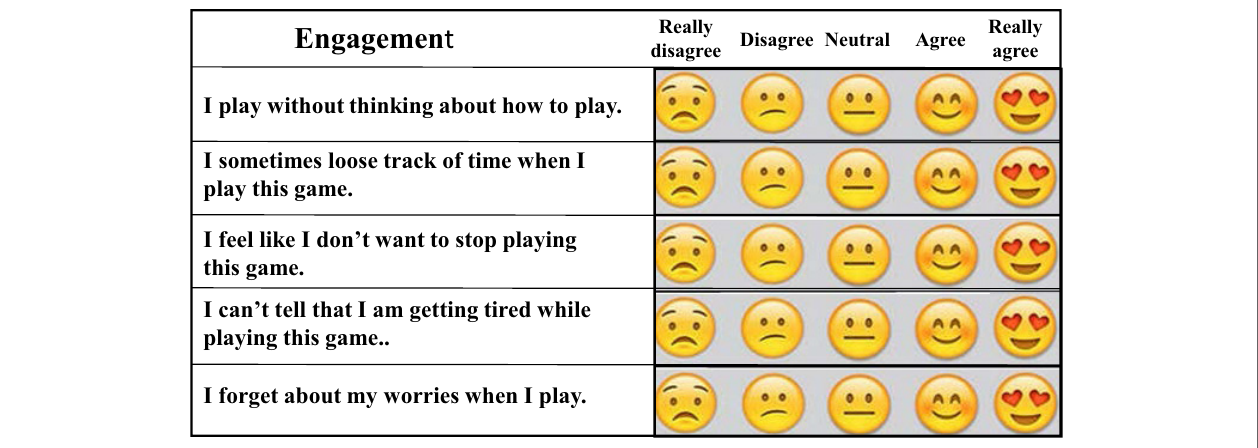
FigUre 9 | For pediatric subjects, three 5-point Likert scale assays, each consisting of five questions, were used to asses usability, engagement, and enjoyment of the prototype Empower Stars! video game. Emoji faces were used instead of five numbers to indicate the degree of subject agreement or disagreement with the statement made, as illustrated here in the section evaluating engagement.